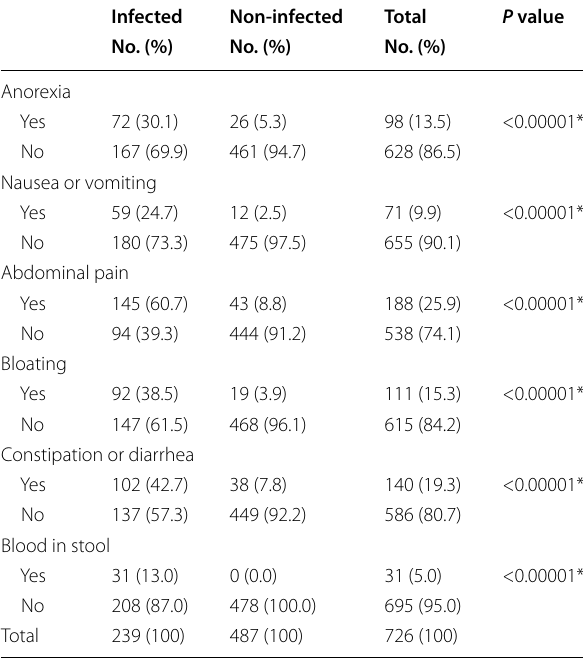
Table 4 Prevalence of GIT disorders among infected and